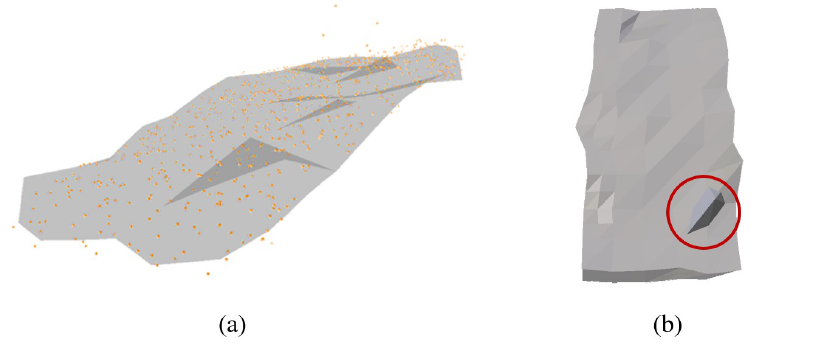
Figure 6. Surface deformation of a low-resolution model ( a ) using updated feature points and ( b ) showing distortion (red